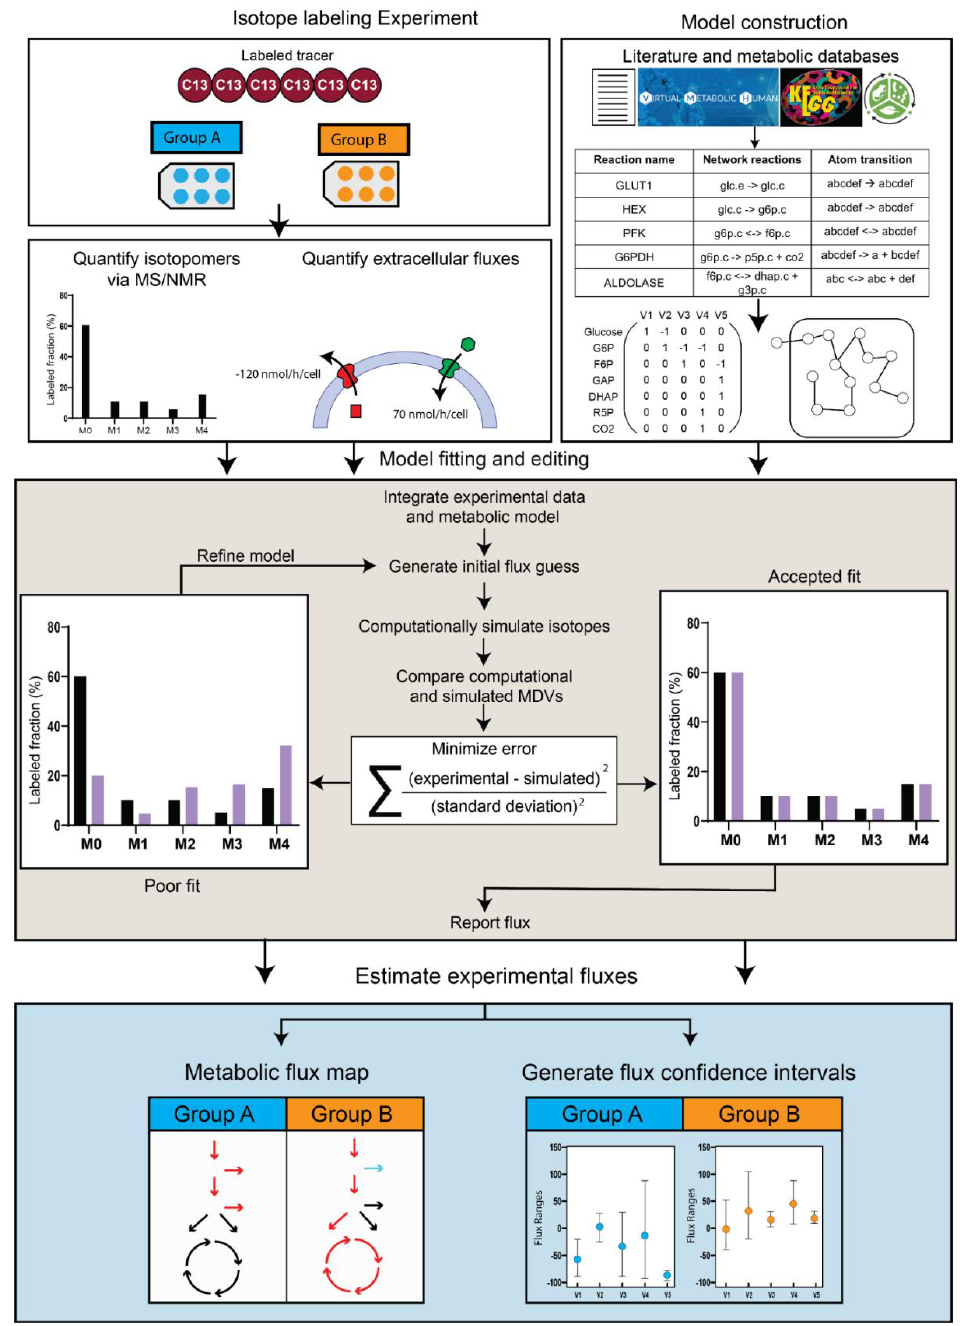
Figure 3. Isotope-assisted Metabolic flux analysis workflow. The three major inputs for iMFA are isotope labeling experiment data, extracellular fluxes, and a metabolic model. The model can be constructed using literature and publicly available databases that delineate the metabolic reactions and atom transitions specific to the organism, tissue, or cell of interest. For most software, this network can be input as a table of reactions along with the corresponding stoichiometry and atom transitions. The table gets converted to a mathematical representation within the user-friendly software. Once the experimental data is fitted to the reaction model, the software generates an initial flux estimate and uses this to computationally simulate MDVs. The fit between simulated and experimentally derived MDVs is assessed, and the process iterates by refining the flux values until a satisfactory fit is achieved. The final flux estimates can be used to output a quantitative metabolic flux map and generate confidence intervals for each flux in the network.